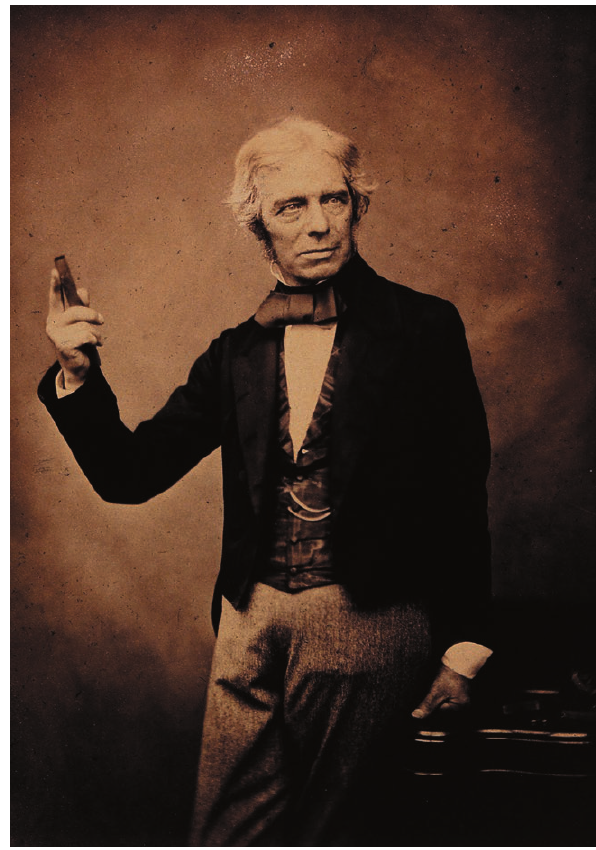
Figure 1. Michael Faraday posing with a tool of trade (a mag- net?). Photograph by Maull & Polyblank. Wikimedia Commons. Photo from the Wellcome Library (ICV No 26801). Photo number: